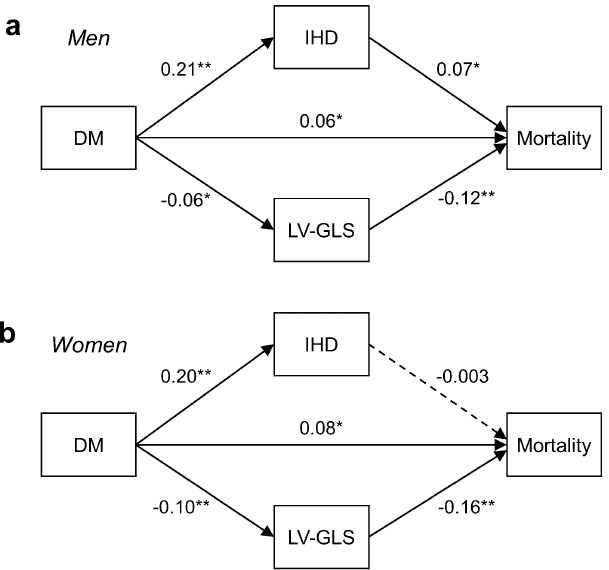
Figure 4. Path diagrams of relationship between DM, LV-GLS or IHD, and mortality by sex. Diagrams of the structural equation model in men ( a ) and women ( b ). Standardized path coefficients are shown on each path as effect estimates. Solid lines denote significant paths and dashed lines, non-significant paths. 5-year mortality data was used. DM = diabetes mellitus; IHD = ischemic heart disease; LV-GLS = left ventricular global longitudinal strain. * p < 0.05, ** p <